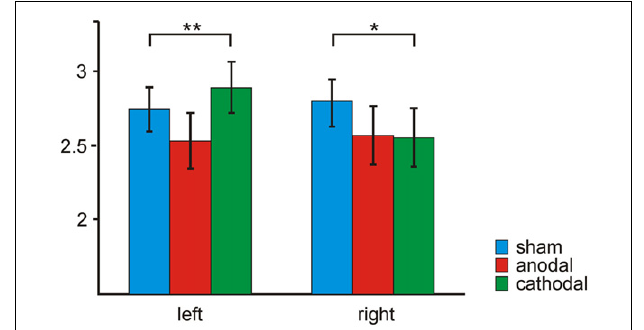
FIGURE 2 |Transcranial direct current stimulation effect on working memory capacity K :WM capacity (K) is given for sham (blue), anodal (red), and cathodal (green) tDCS of the right parietal cortex separately for attended stimuli in the left and right hemifield.